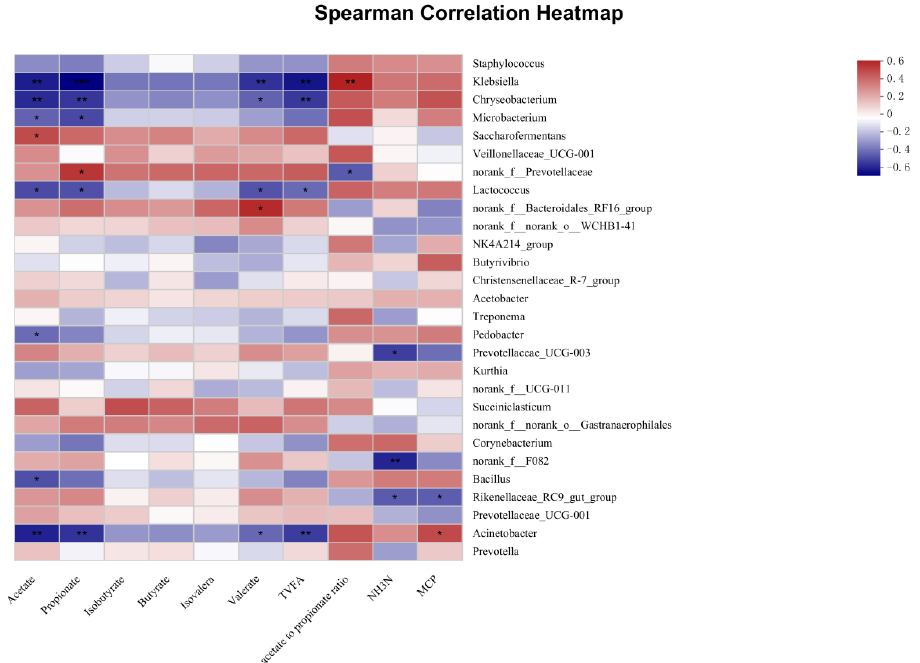
Figure 5. Correlation analyses between the fermentation characteristics and the top 28 rumen bacterial genera. In the two-dimensional heat map, the change in defined color and its depth indicates the nature and strength of the correlation, respectively. An asterisk sign was used when the r value was greater than 0.1 and the p values were less than 0.05 (* p < 0.05, ** p < 0.01, *** p < 0.001).